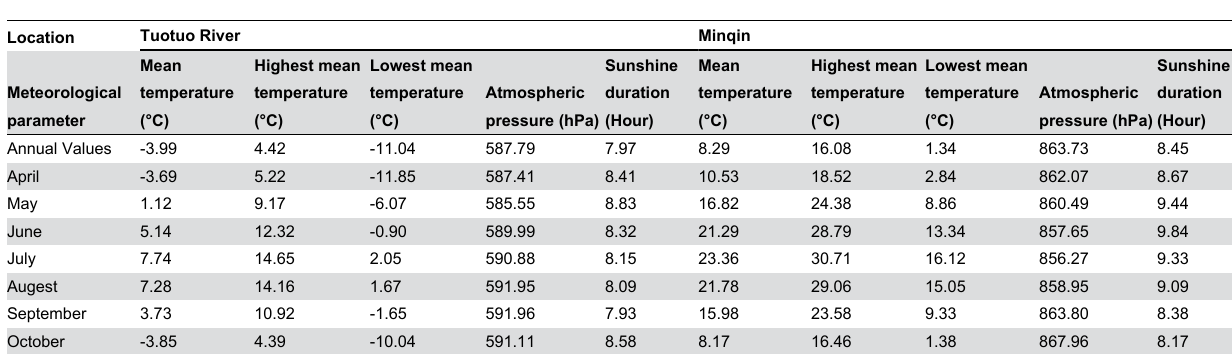
Table 1. Climatic data of Tuotuo River and Minqin from 1959 to 2009.